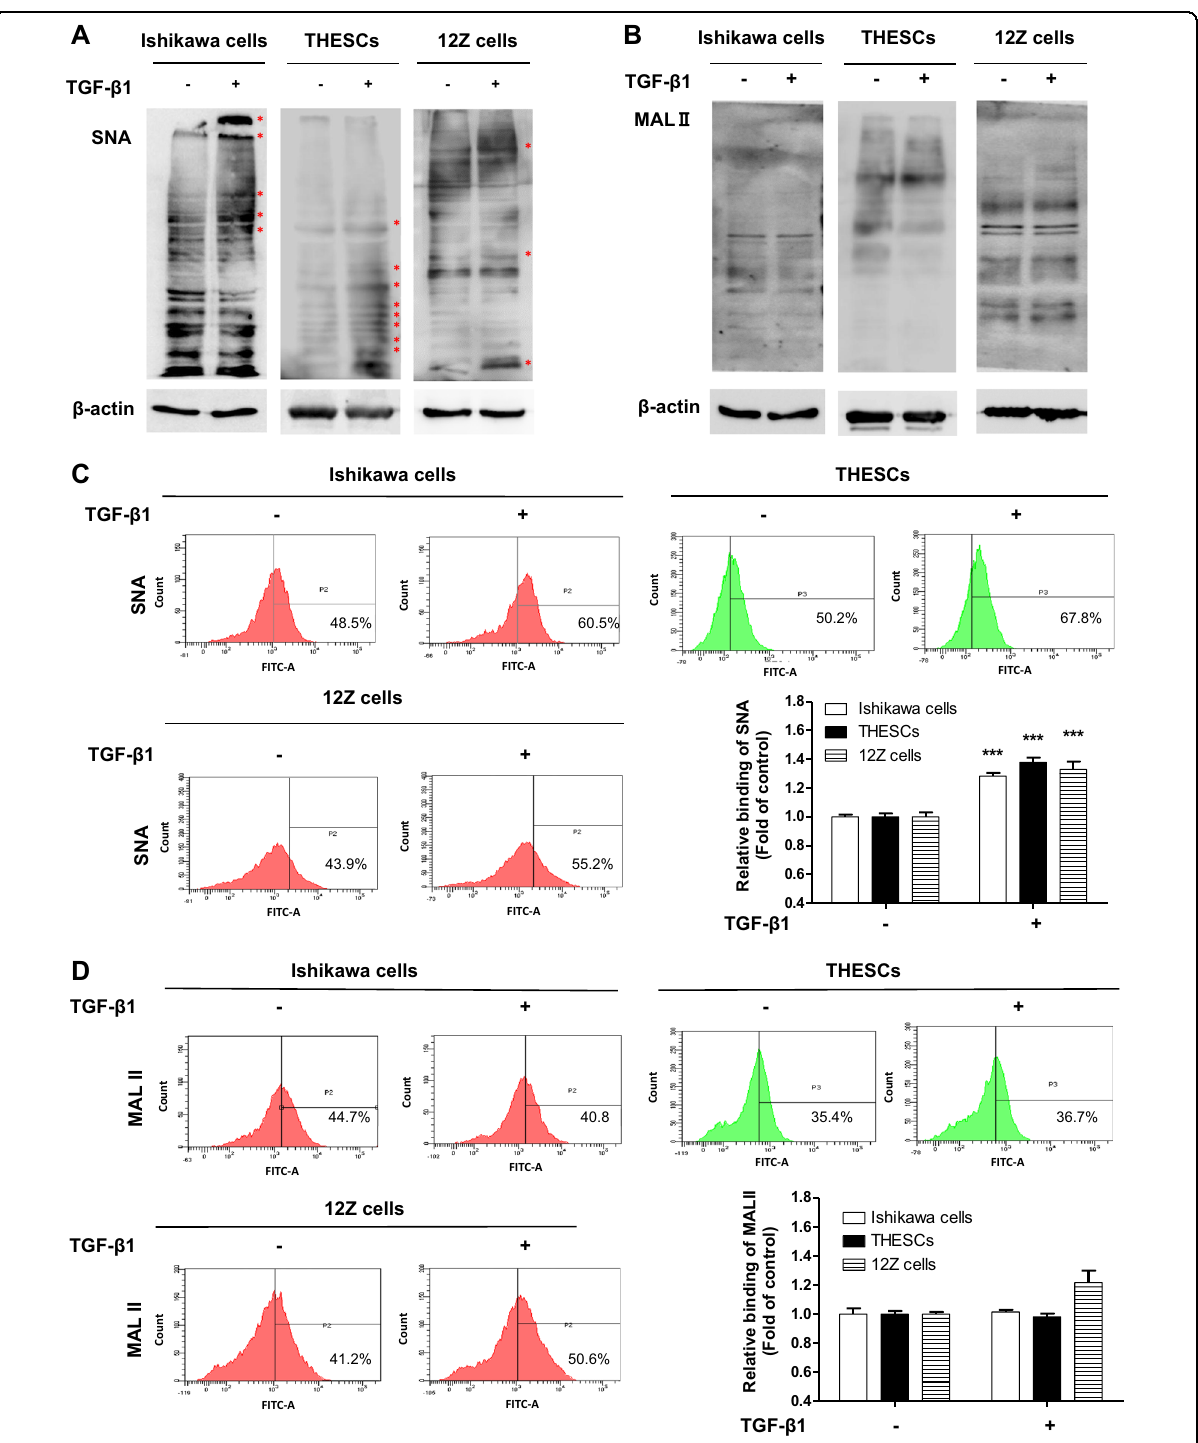
Fig. 2 α 2-6 Sialylation of endometrial cells is increased by TGF- β 1 treatment Ishikawa, THESCs, or 12Z cells were incubated with TGF- β 1 for 48 h. The expression of α 2-3 or α 2-6 sialic acid epitopes in endometrial or endometriotic cells was determined by lectin blot a , b or lectin FACS analysis c , d using biotin-labeled MAL II and SNA, respectively. Data from the lectin FACS analysis are expressed as the mean ± SD of three independent experiments. Red asterisk indicates increased protein expression in the TGF- β 1-treated group compared with the control group. * p < 0.05 and *** p < 0.001 compared with the control